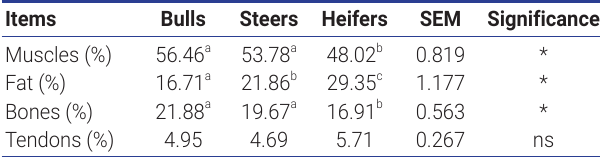
Table 3. Physical composition of three-rib sections Items